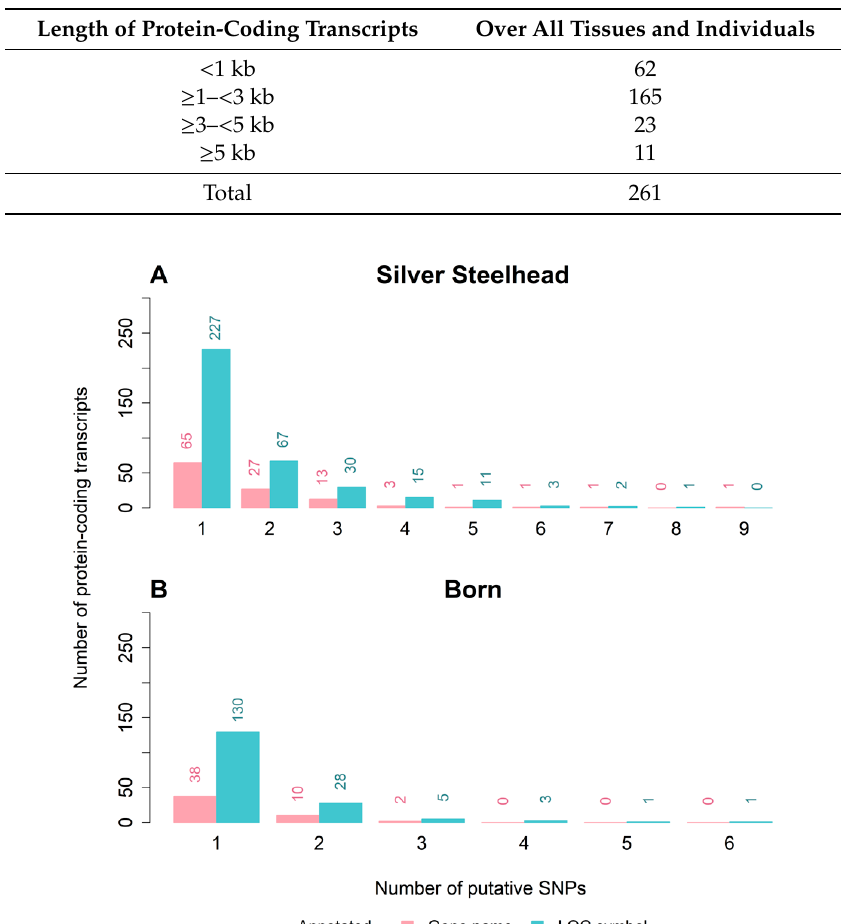
Figure 4. Number of heterozygous SNPs in annotated protein-coding transcripts with gene name (red) or LOC symbol (blue) in the Born strain ( A ) and the Silver Steelhead strain ( B